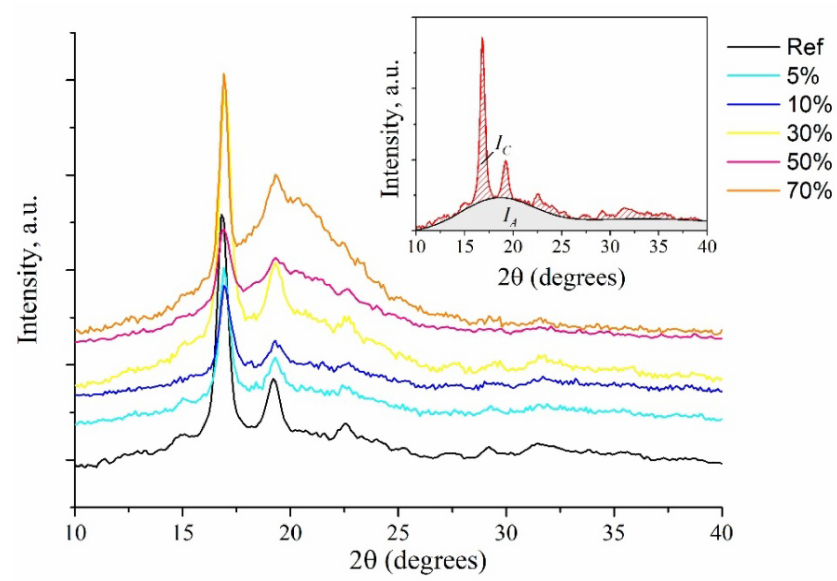
Figure 10. XRD patterns of PLA and PLA + OTOA samples (0–70%). The inset shows the determina- tion of I A and I C areas used for the degree of crystallinity